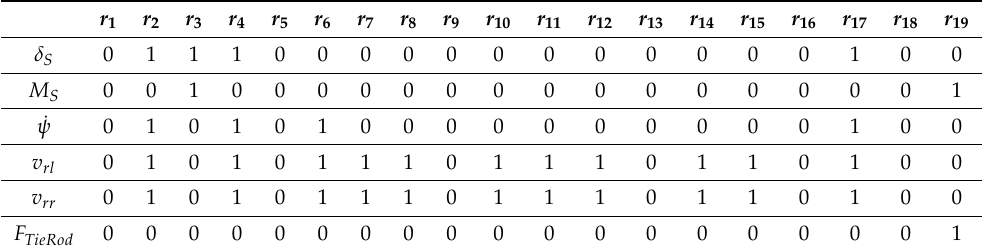
Table 1. Fault–symptom relationships of r 1 to r 8 for condition monitoring of six sensors: the